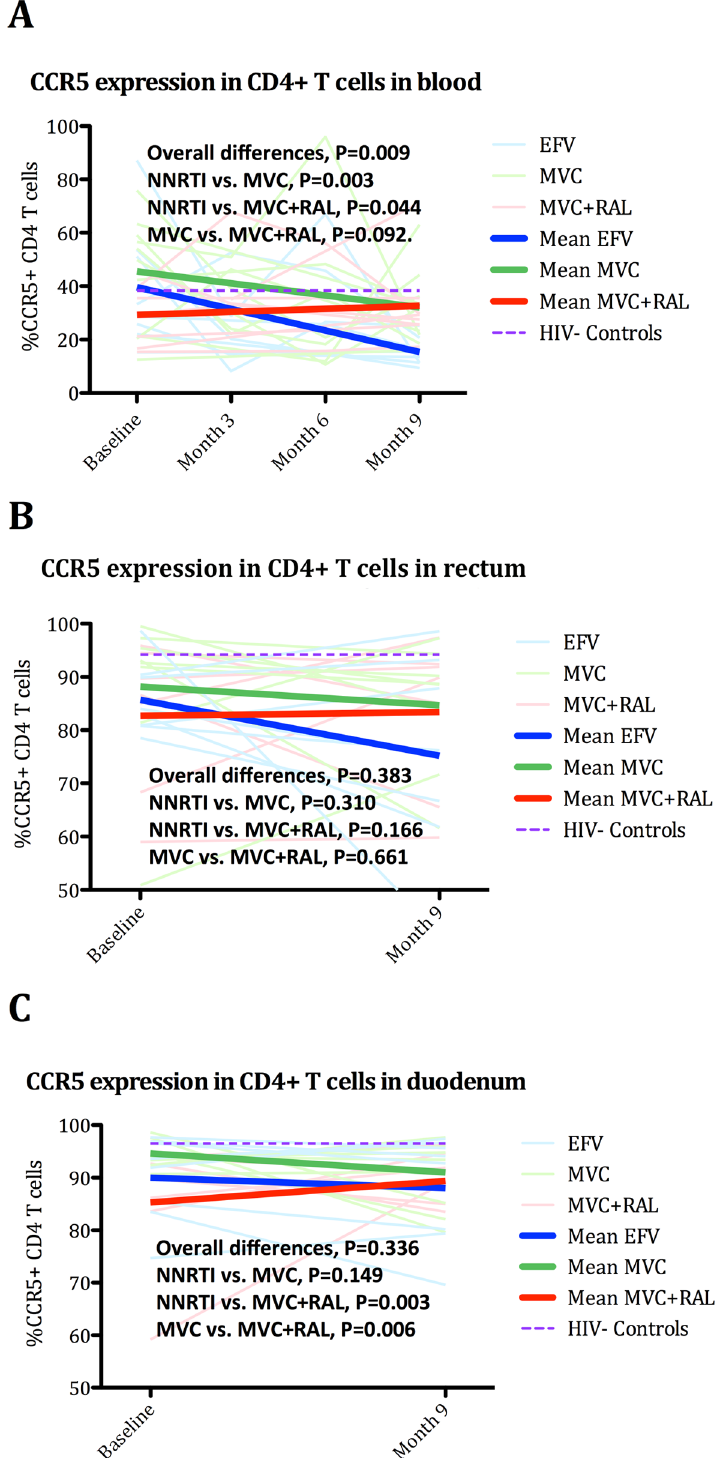
Fig 5. Changes in %CCR5 T-cells in blood, rectum and duodenum. Panel A. Changes in %CD4 + CCR5 + T-cells in blood. Panel B. Changes in %CD4 + CCR5 + T-cells in rectum. Panel C. Changes in %CD4 + CCR5 + T-cells in duodenum. The Purple dash line represents cross-sectional mean values in controls. The equality of all mean changes among the three groups was tested using a Wald test for the interaction term and